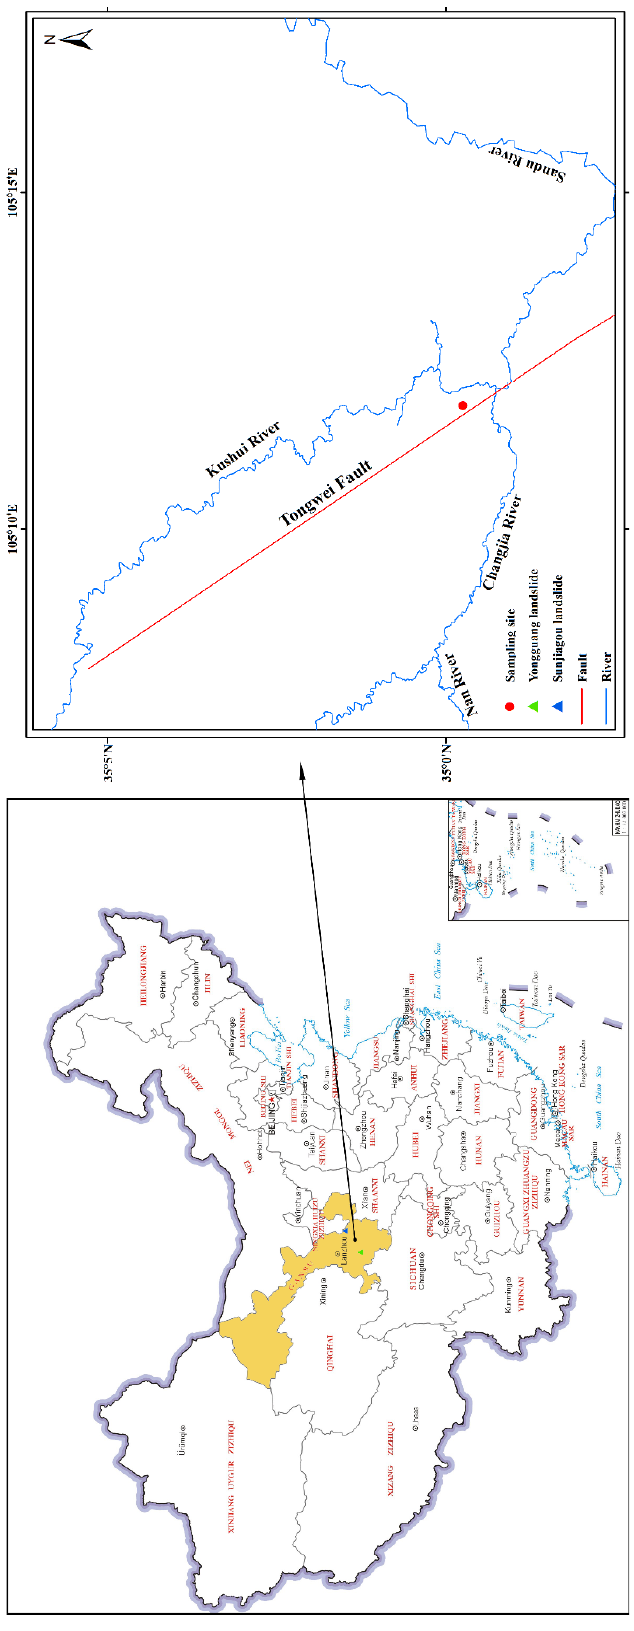
Figure 2. Location of the sampling site.